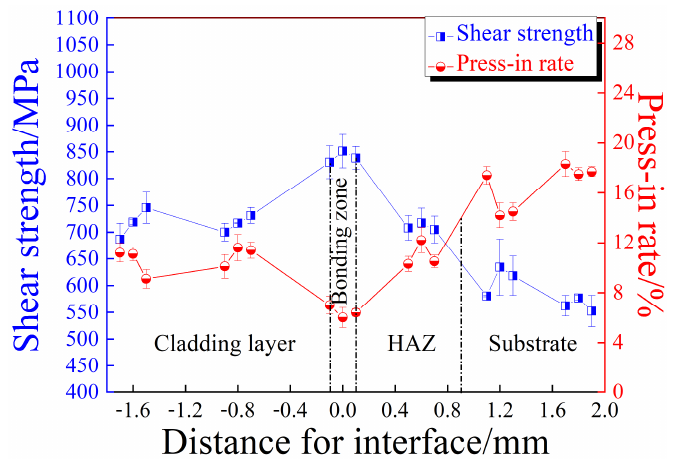
Figure 14. Gradient curve for the properties of the cladding cross-section.